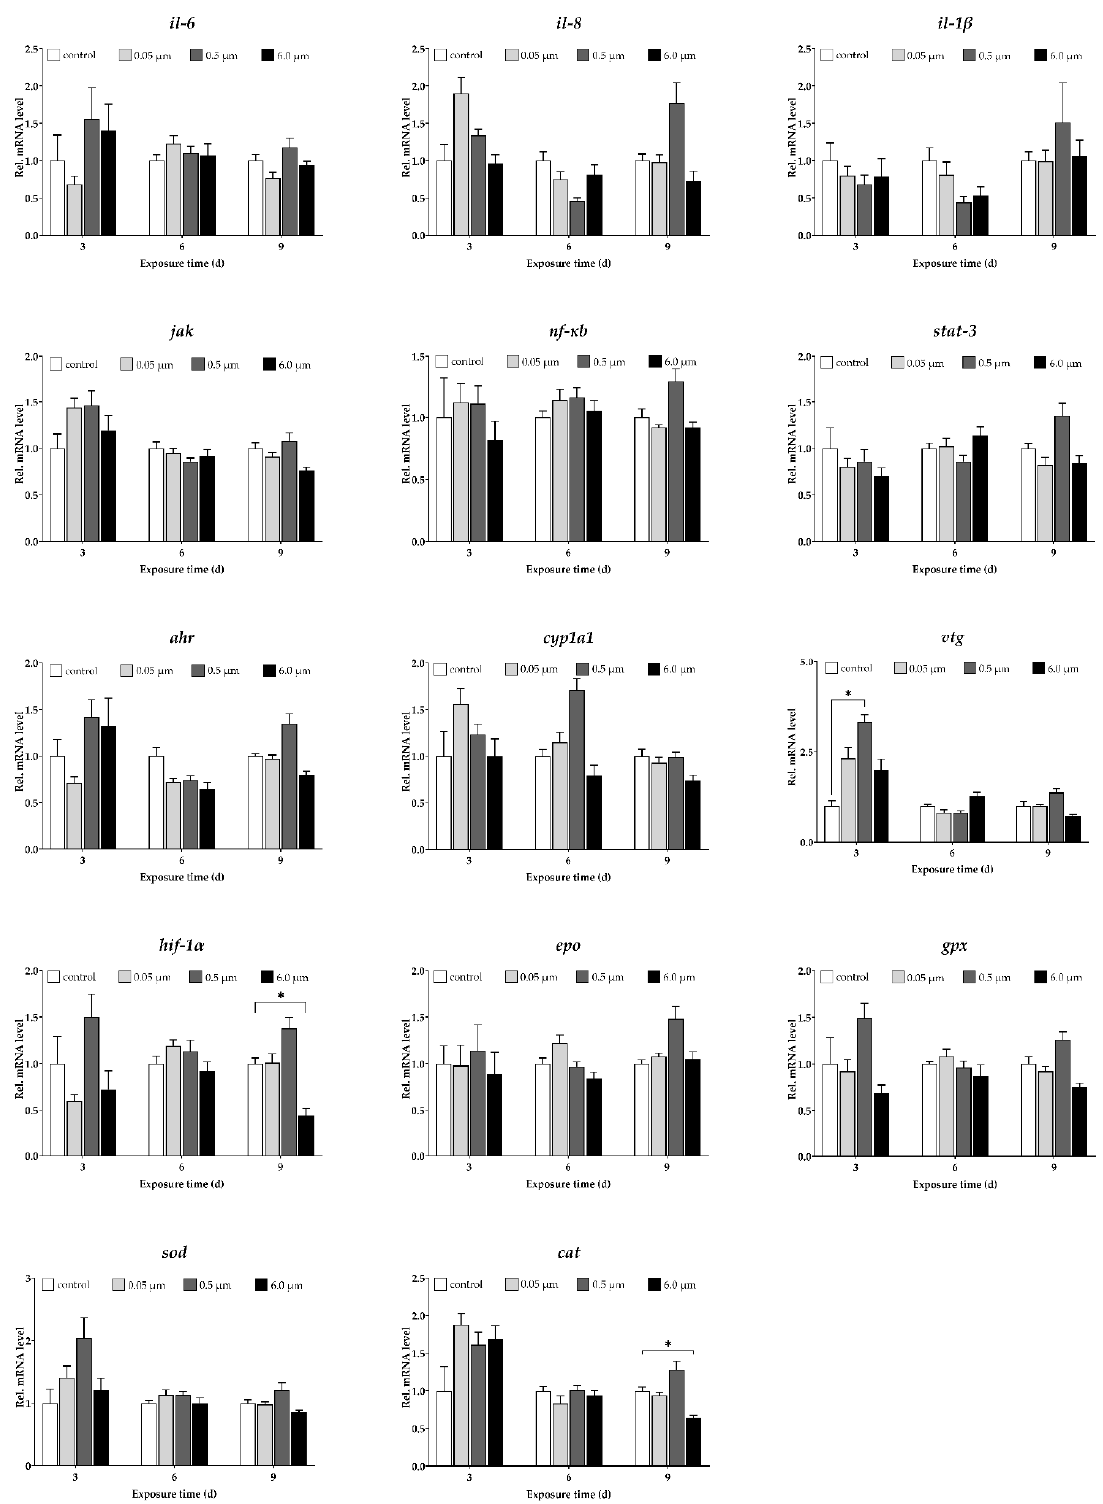
Figure 5. Changes in the relative expression levels of the related genes of embryos exposed to PS-MPs of different sizes for 3, 6, and 9 dpf (n = 6). Asterisks indicate significant difference between the treatment group and the control at each time point (* p <